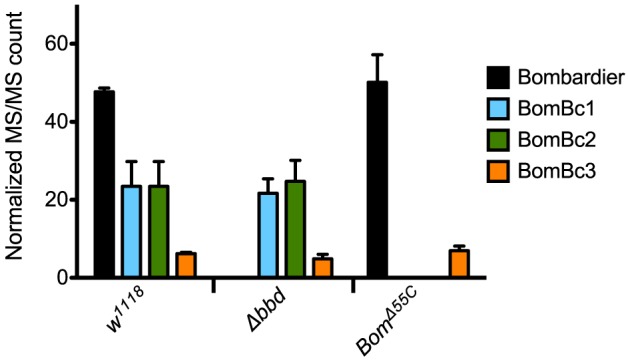
The presence of bicipital Bomanins in hemolymph is unaffected by loss of Bombardier. MS/MS counts for the indicated proteins as determined by Andromeda/MaxQuant were normalized to total MS/MS counts in each run. Error bars represent standard deviation for biological replicates (n = 3 for Δbbd and BomΔ55C, n = 2 for w1118). Supplemental Table 3 shows the full dataset.